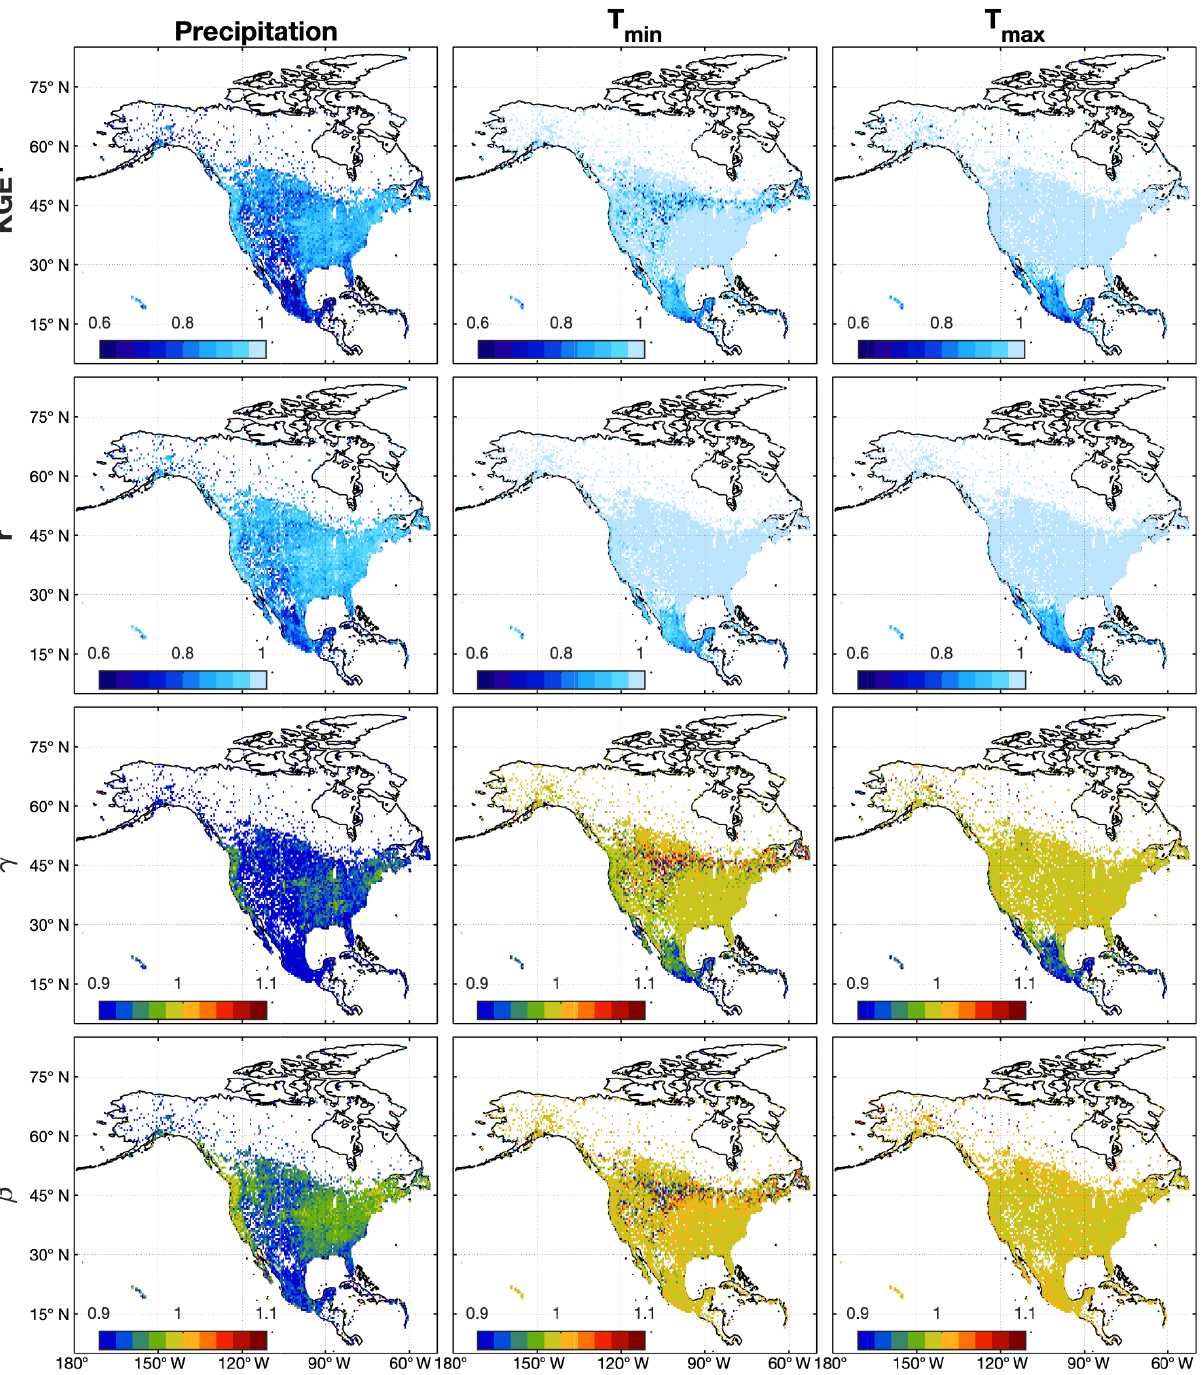
Figure 12. The spatial distributions of KGE (cid:48) and its three components ( r is the CC, β is the bias ratio, and γ is the variability ratio) for uncorrected SCDNA estimates over North America during the observation period. The maps are at a resolution of 0.5 ◦ . The value for each grid cell is the median value of all stations within this grid